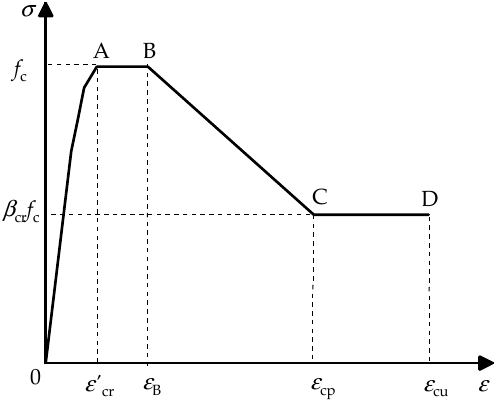
Figure 4. Constitutive model of concrete at rectangular area.